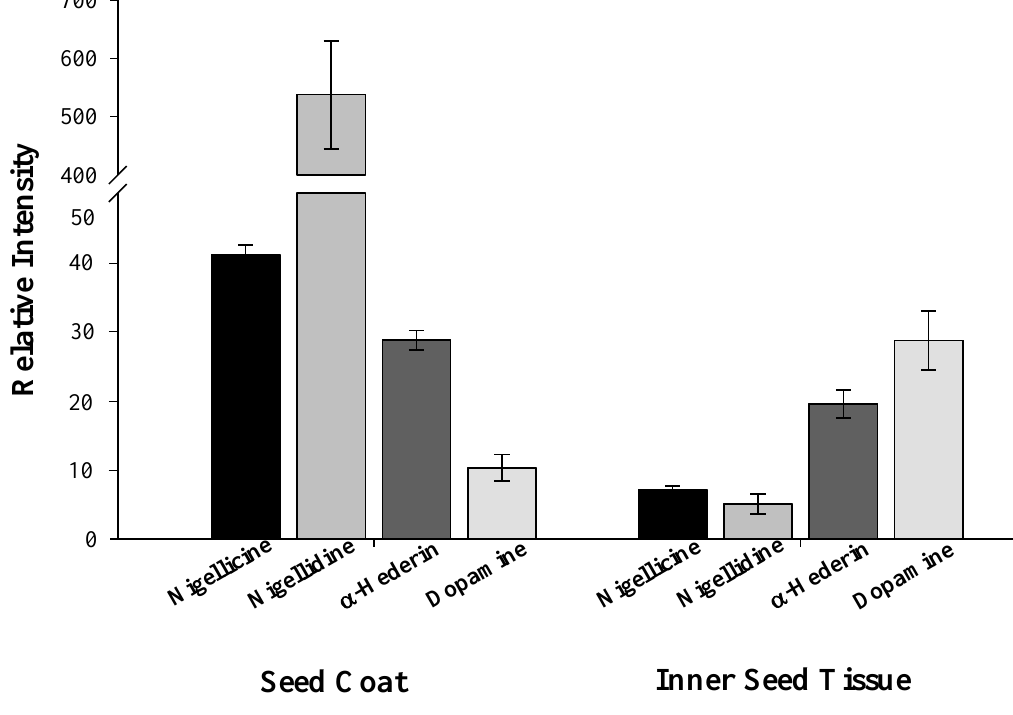
Figure 6. Distribution of alkaloids and α-hederin in seed coats and inner seed tissues.of N. sativa. Analyses were performed on a UPLC-Q-TOF-MS, except for dopamine, that was detected by GC-MS. Relative content is given as the metabolite response (metabolite peak intensity/internal standard peak intensity/FW). The error bars in graphs refer to the mean values ± SE of four replicates. In all cases significant differences were noted between the metabolite levels in seed coats as compared to the endosperm tissues ( t test, p <